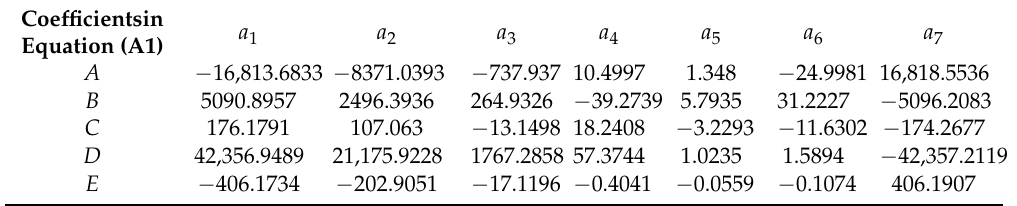
Table A2. Coefficients in Equation